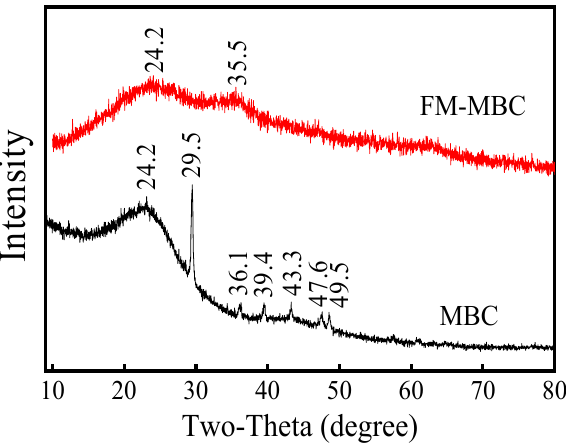
Figure 2. XRD spectrum of MBC and FM-MBC.